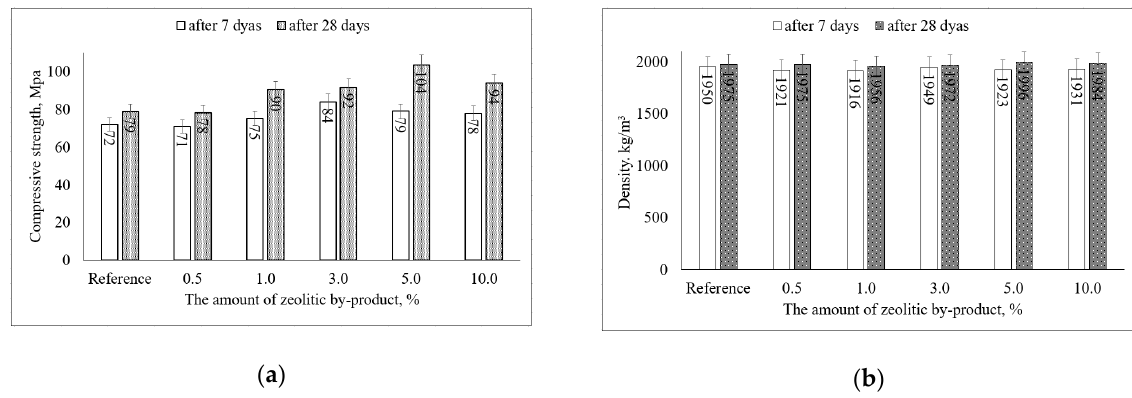
Figure 4. Compressive strength ( a ) and density ( b ) of hardened cement paste samples containing different amounts of zeolitic by-product.